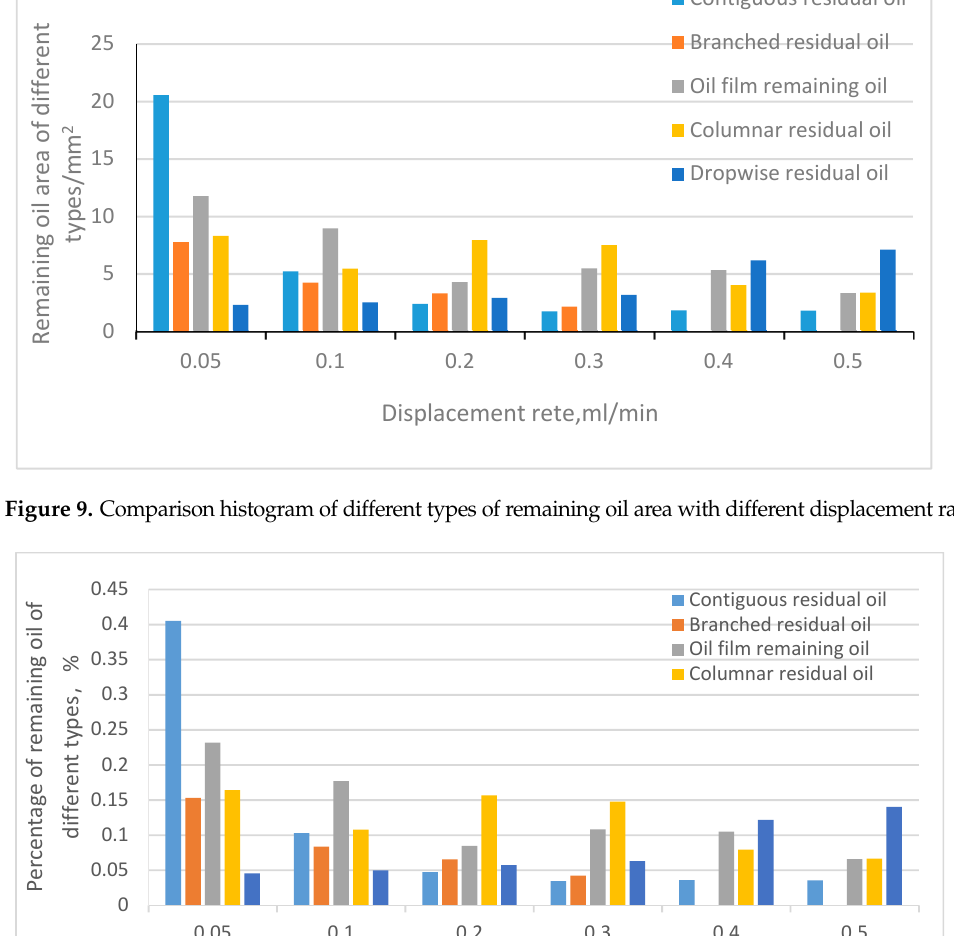
Figure 10. Comparison histogram of different types of remaining oil ratio with different displacement rates.